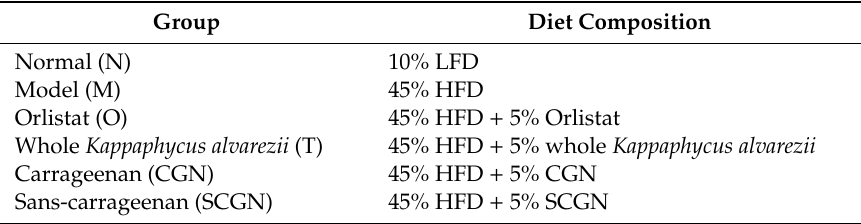
Table 1. Treatment groups for animal